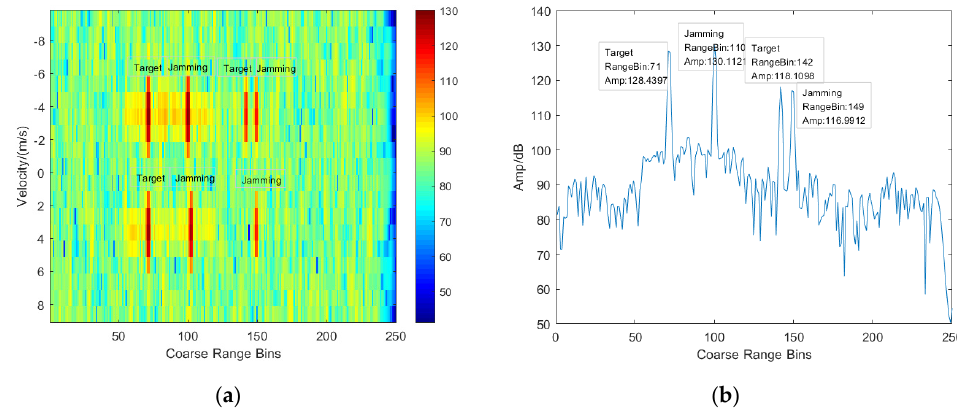
Figure 4. Echo plane after matched filtering for frequency non-agile case. ( a ) Coarse range–velocity plane; ( b ) Range plot at the velocity of -3.5m/s.